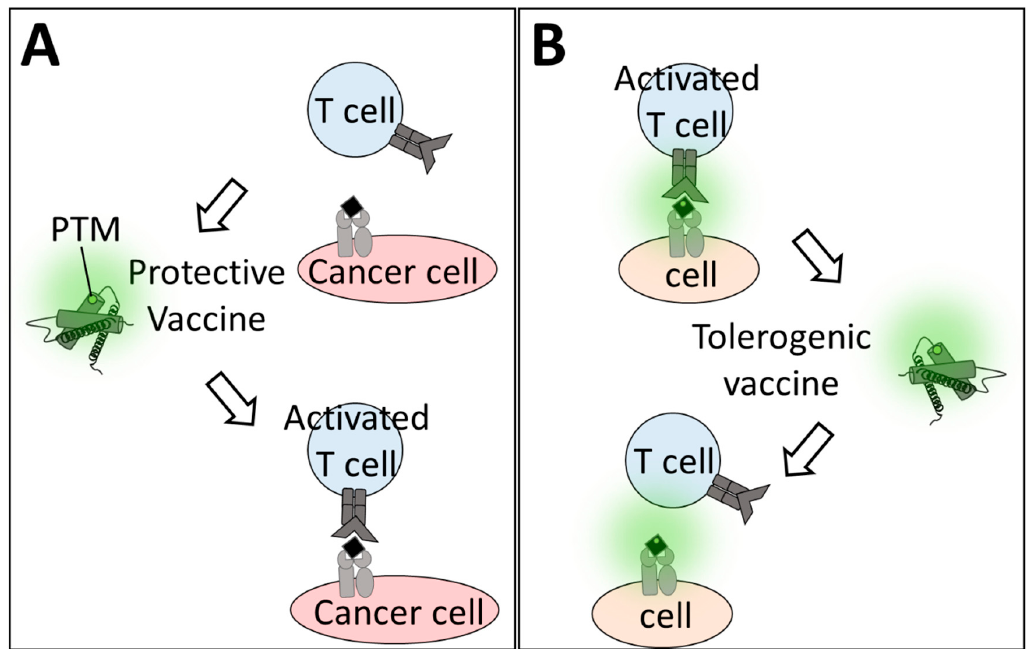
Figure 3. Modified proteins as therapeutics. Vaccination with oxPTM proteins alters antigen-specific T cell activation. ( A ) Cancer cells evade immune response due to the expression of “self” antigens, and the oxPTM vaccine enlarges the T cell repertoire to enable T cell activation. ( B ) In oxPTM-induced diseases, vaccination with modified proteins can dampen by increasing the threshold that is needed for activation.